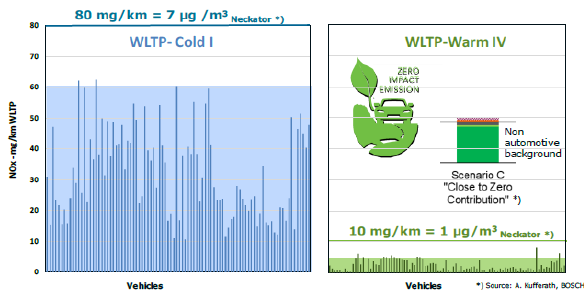
Fig. 5. Emission behavior of EU6dtemp vehicles with Gasoline